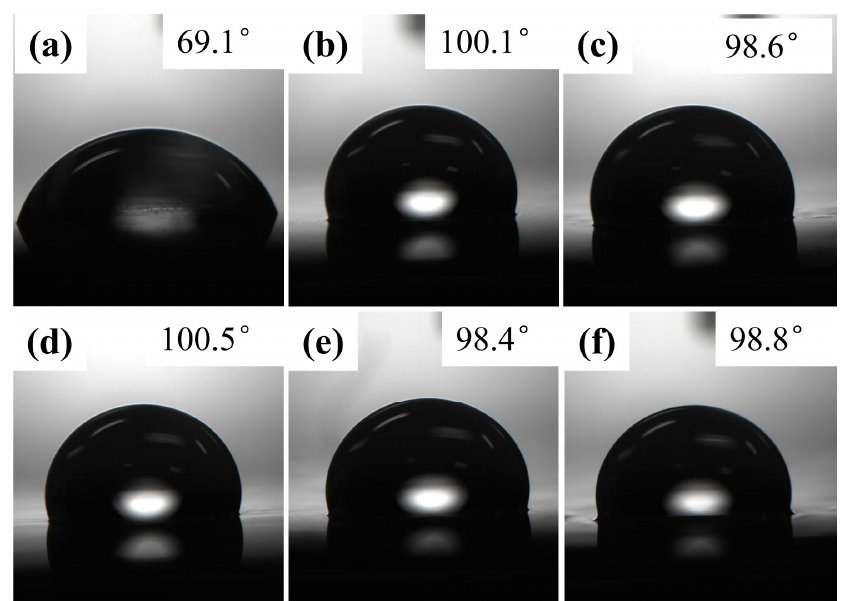
Figure 4. Contact angle of bare Al ( a ) and the SLIPS filled with 10 mPa·s ( b ), 20 mPa·s ( c ), 50 mPa·s ( d ), 100 mPa·s ( e ), and 200 mPa·s ( f ) of silicone oil.